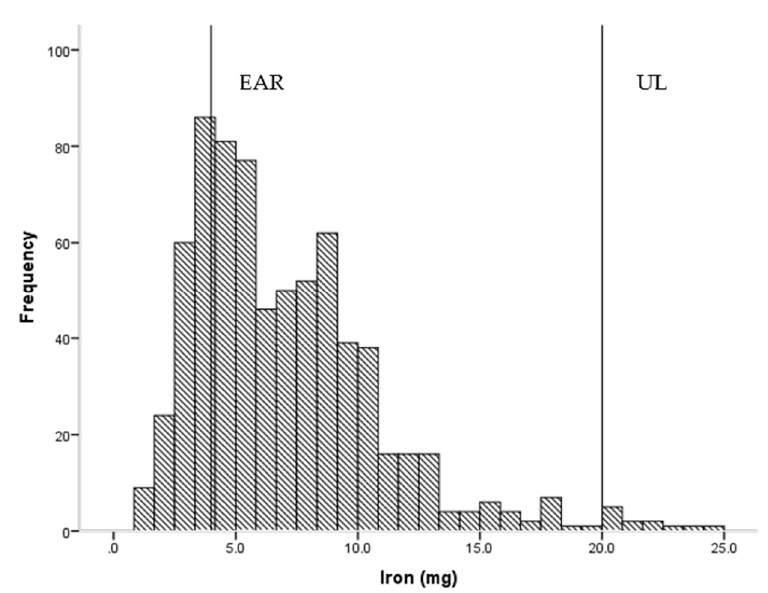
Figure 1. Frequency of intake of iron ( n = 714) showing estimated average requirement (EAR = 4 mg) and upper limit of intake (UL = 20 mg).